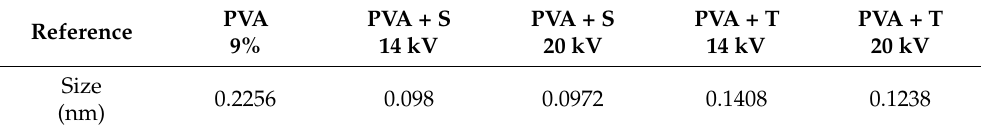
Table 5. Nanofiber cross-section dimensions